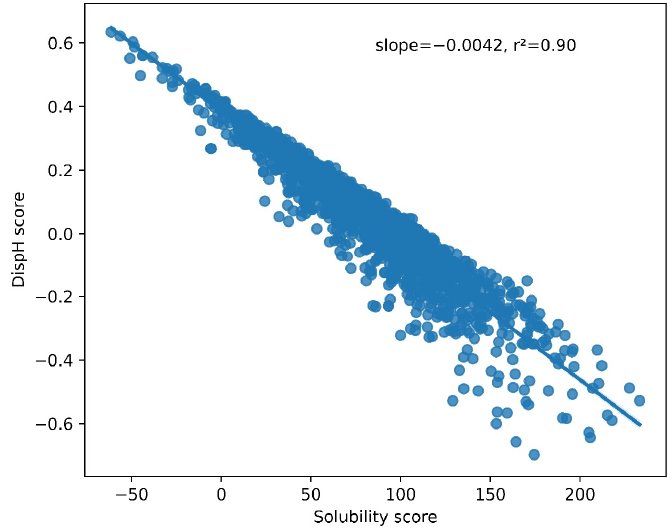
Figure 3. Correlation between LLPS-DR disorder and solubility scores at pH 7.0. A significant linear correlation can be observed (R 2 = 0.90, p < 1 − 10 ). Higher solubility scores are associated with lower − 10 ). Higher solubility scores are associated with lower DispH scores (more disordered states). correlation can be observed (R 2 = 0.90, p < 1 DispH scores (more disordered